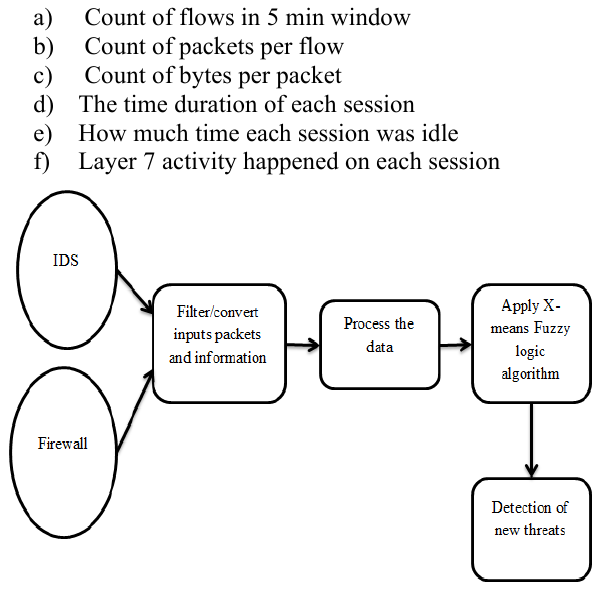
Figure 7. Hybrid threat detection system